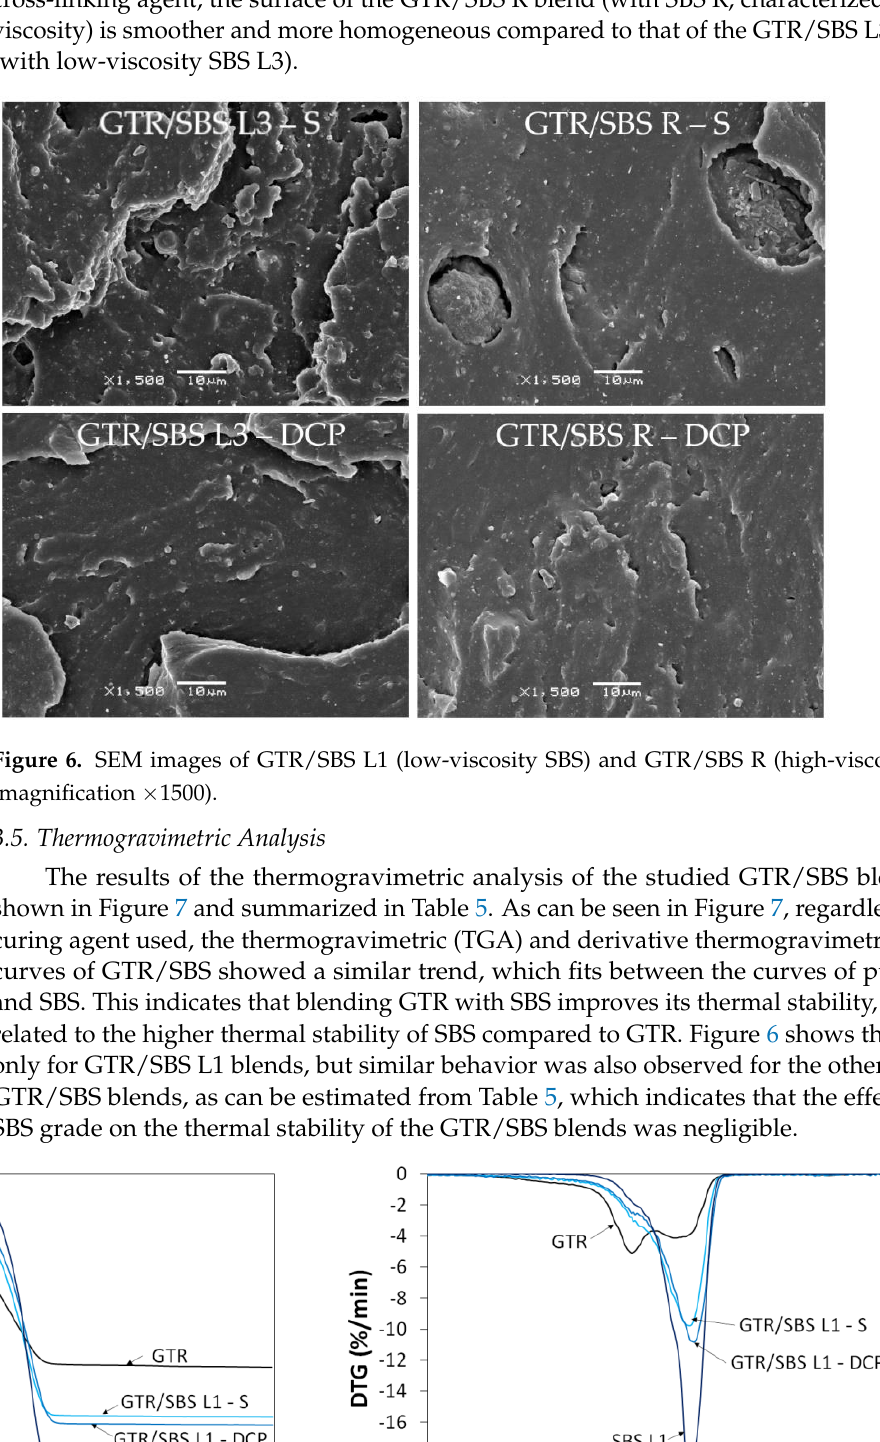
Table 5. Thermal decomposition temperatures and residue mass of GTR/SBS blends.